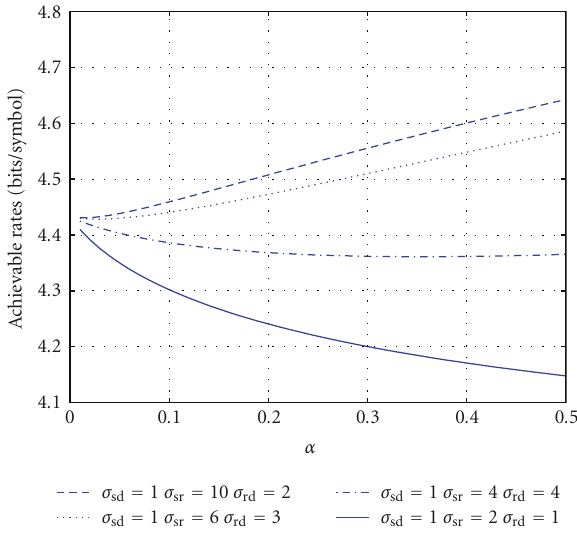
Figure 7: Overlapped AF achievable rate versus α when P s = P r = 50, δ s = δ r = 0 . 1, and m =